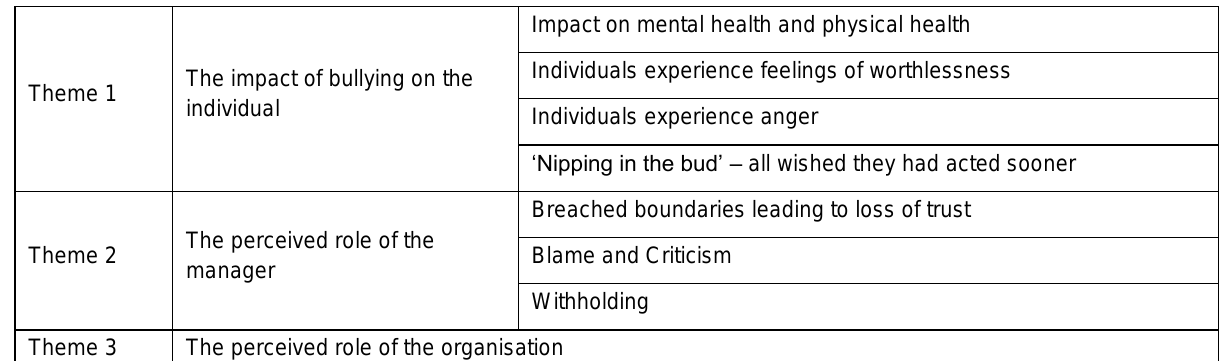
Table 3: Themes and Sub-